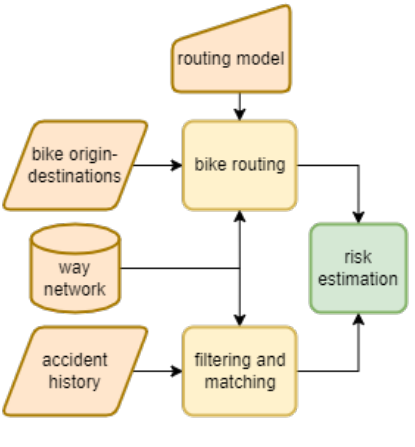
Figure 3. Data processing diagram.